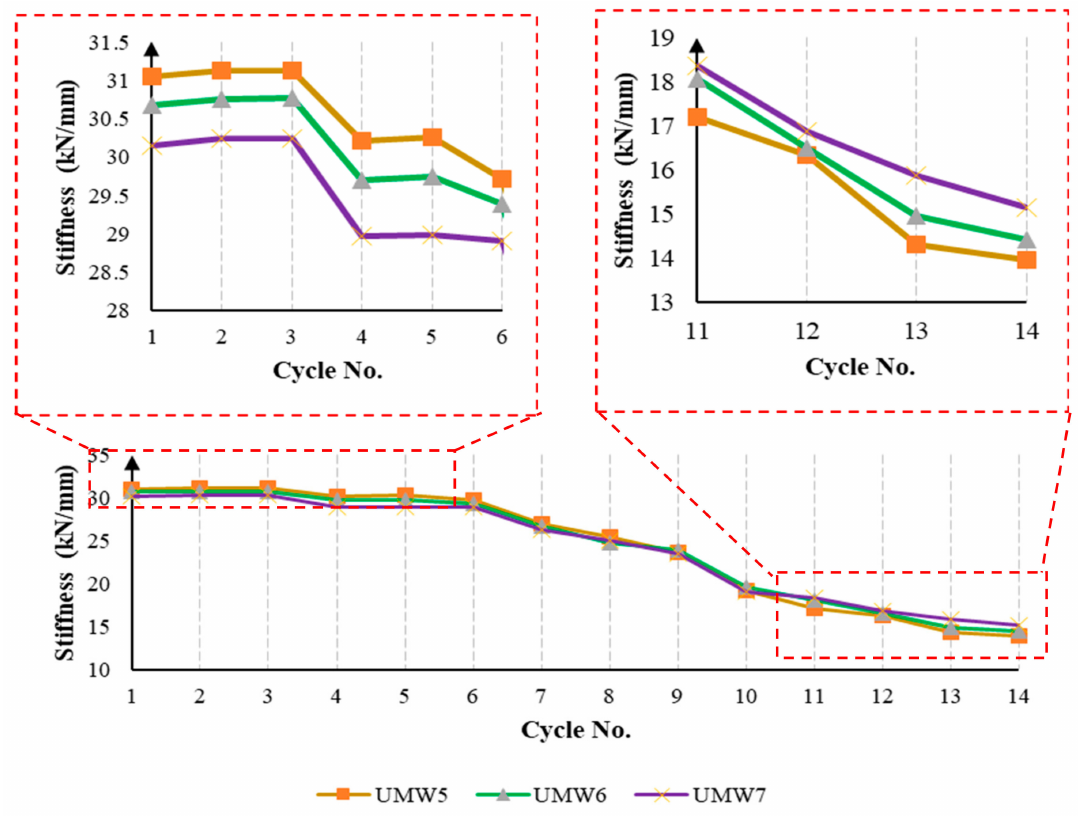
Figure 17. The stiffness reduction in the cross-strip masonry walls during the